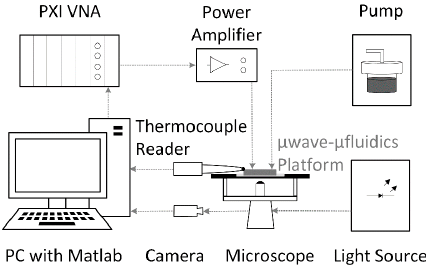
Figure 6. The block schematic of the microwave-optical-fluidic measurement setup.